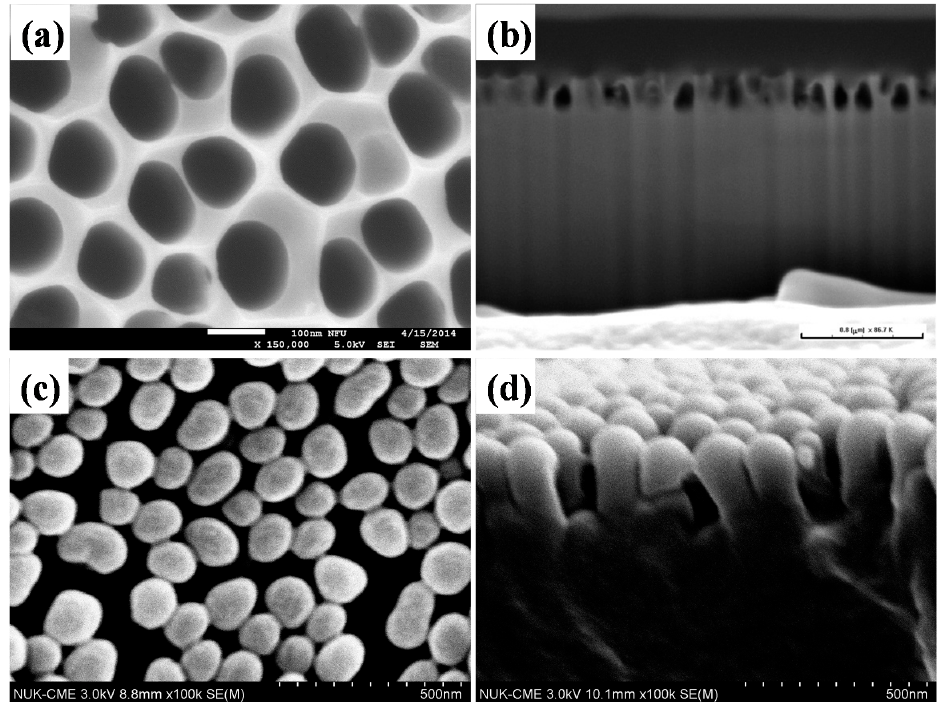
Figure 2. FE-SEM top-view and cross-sectional of an anodic aluminum oxide (AAO) template and polymethyl methacrylate (PMMA) film with subwavelength moth-eye structures. ( a , b ) top-view and cross-sectional of AAO template; ( c , d ) top-view and cross-sectional of PMMA film with subwavelength moth-eye structures.